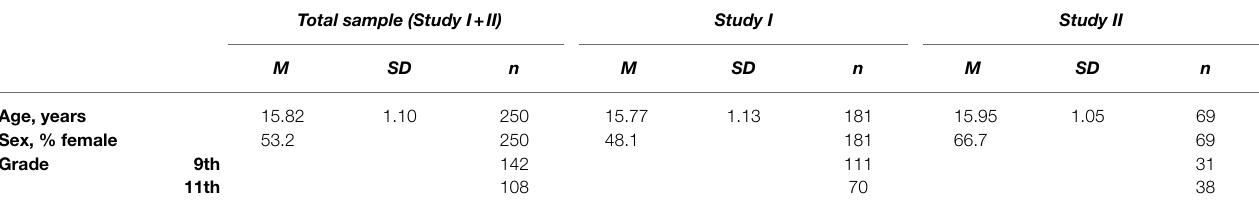
TABLE 1 | Demographic data from the studies.